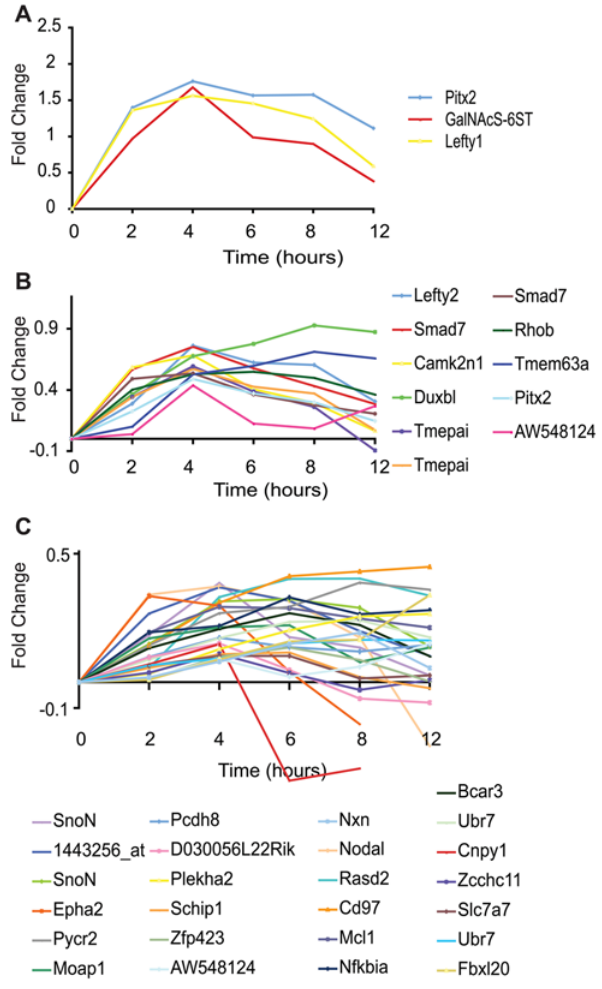
Figure 4. Expression profile of target-genes downstream a Smad2/3 activation time-course in the absence of protein synthesis. Microarray data from TAG1 ES cells under Smad2/3 activation in the absence protein synthesis, as described in Figure 6. The expression of individual genes was analysed and plotted as trends over time. Relative level of gene expression is represented as the log values of fold change (the y-axis) against time (x-axis). All samples were normalised to the time point 0. Genes are classified in 3 groups according to the level of response at time point 4 hours compared to 0. (A) High responding genes, showing $ 10.0-fold increase. (B) Medium responding genes, showing $ 2.5- to , 10.0-fold increase. (C) Last group comprising the low responding genes ( $ 1.2 to . 2.5- fold increase). For all values see Table 3.